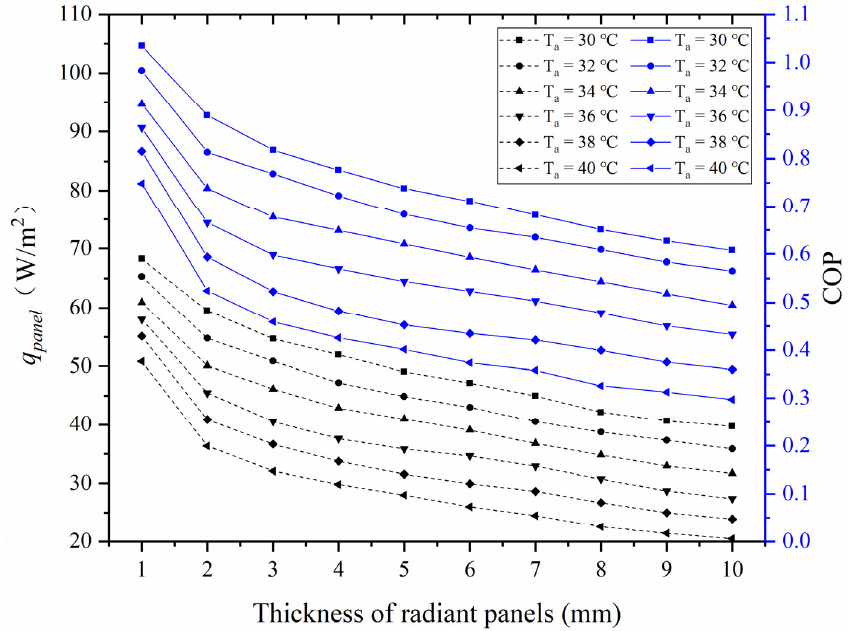
Figure 6. System cooling capacity and cooling performance at different radiant panel thicknesses.